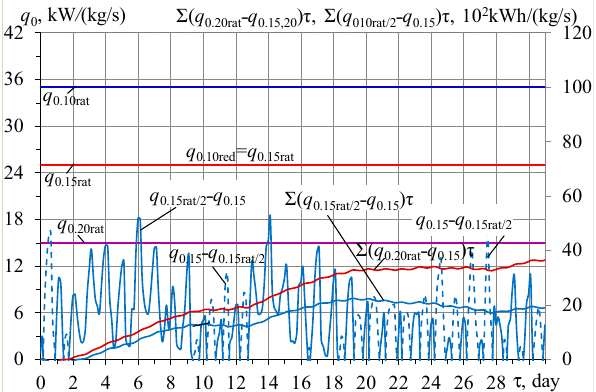
Figure 9. Reduced rational value q 0.10red = q 0.15rat for conditioning outdoor air to 10 ° С using reserved refrigeration energy, actual refrigeration capacities q 0.15 needed for conditioning outdoor air to 15 ° С , reduced refrigeration capacity q 0.15rat/2 exceedance q 0.15rat/2 − q 0.15 above q 0.15 and its deficit q 0.15 − q 0.15rat/2 ,